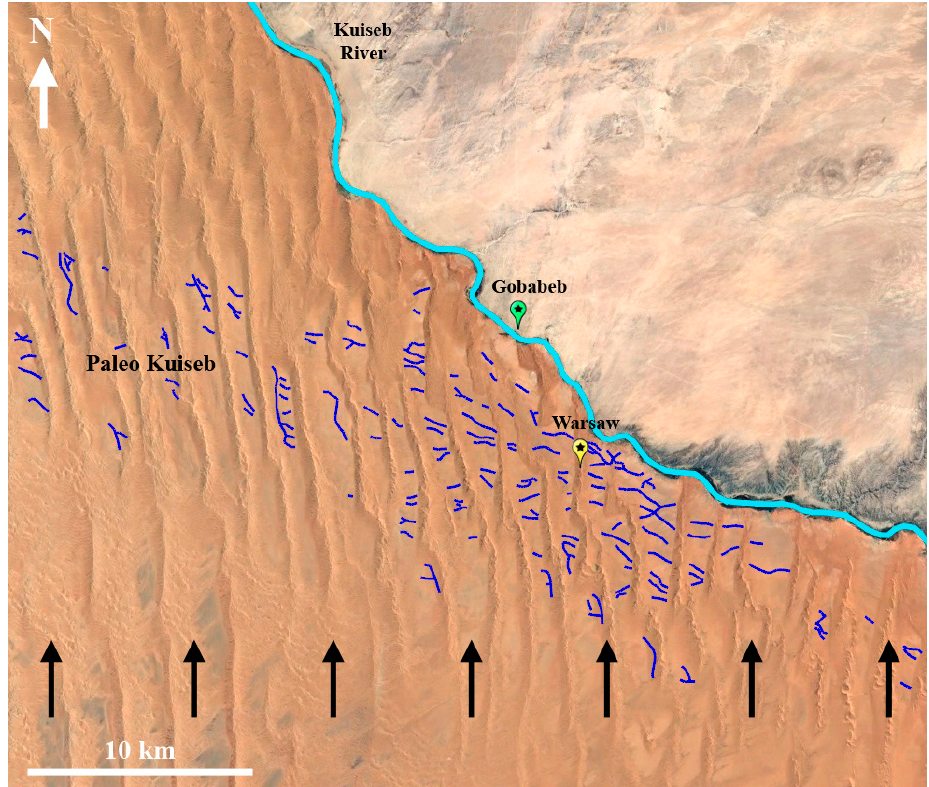
Figure 8. Location of Warsaw dune, present-day Kuiseb riverbed (cyan) and Paleo–Kuiseb system (dark blue), spreading over 8 km in south–north direction. Dark arrows indicate the main migration direction of Namib sand dunes.